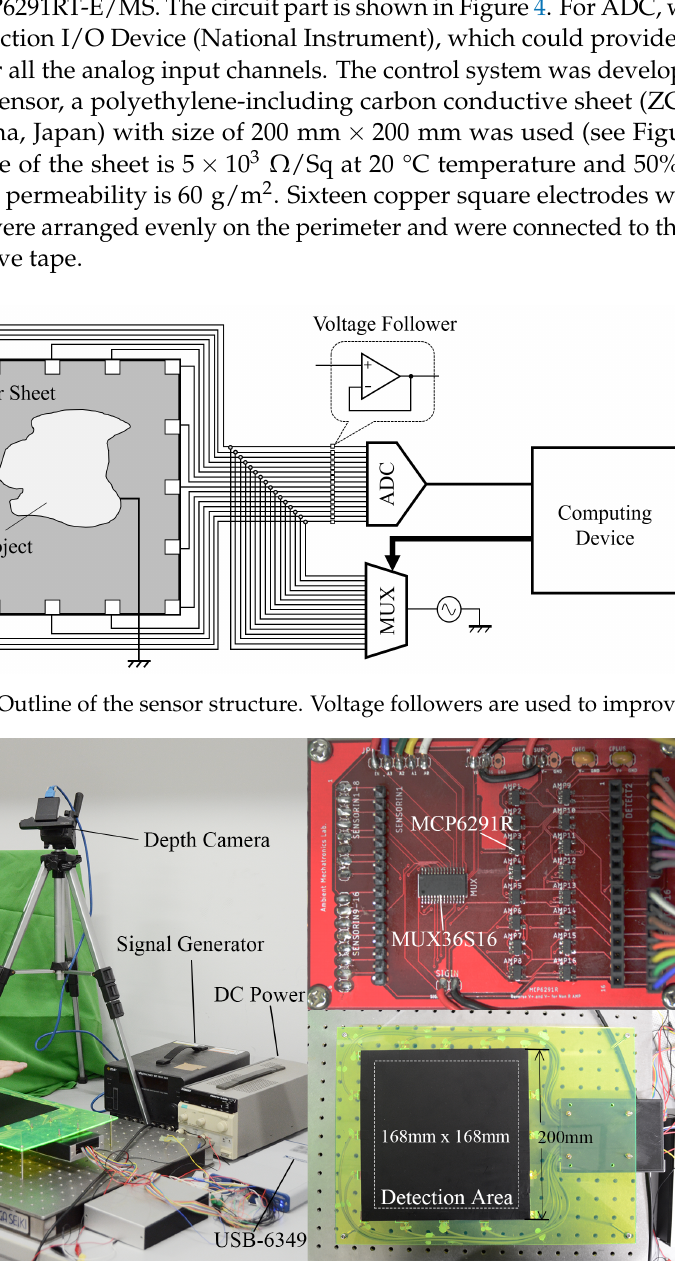
Figure 4. Sensor construction, circuit, and detection